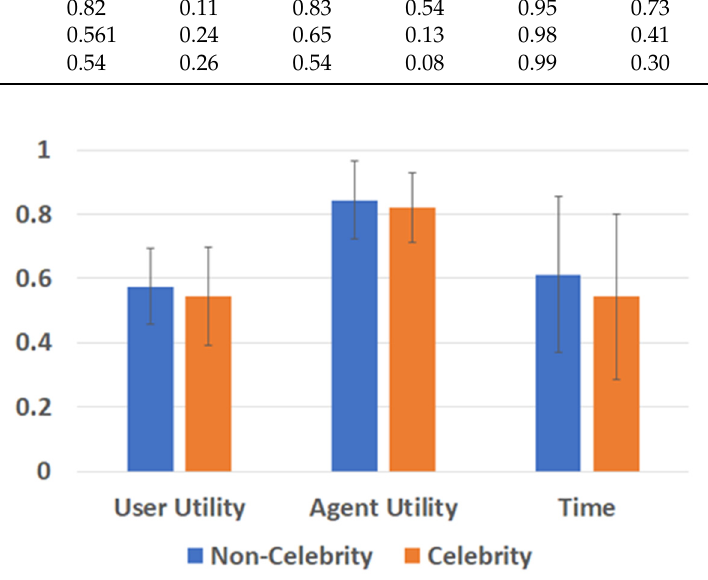
Figure 9. Mean with Error Bars of Negotiation Performance Metrics (participants with positive feel- ings).